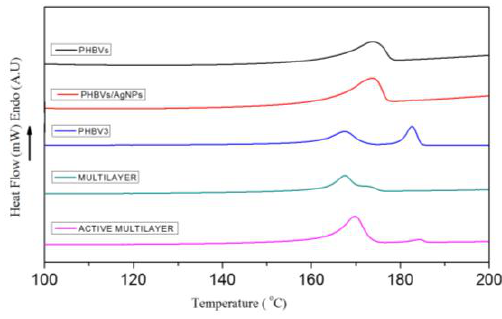
Figure 5. Differential scanning calorimetry (DSC) thermograms of first heating run of the neat electrospun fibers and films and their silver-based coating system.